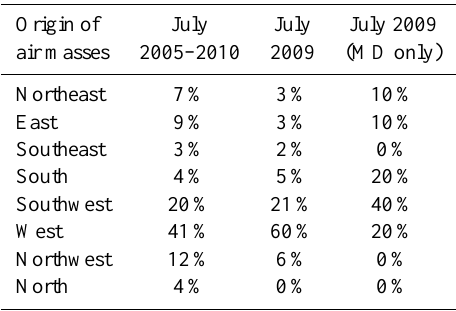
Table 3. Comparison of air mass origin determined from backward trajectories in the month of July between 2005 and 2010, observed in July 2009 and observed in July 2009 for MD